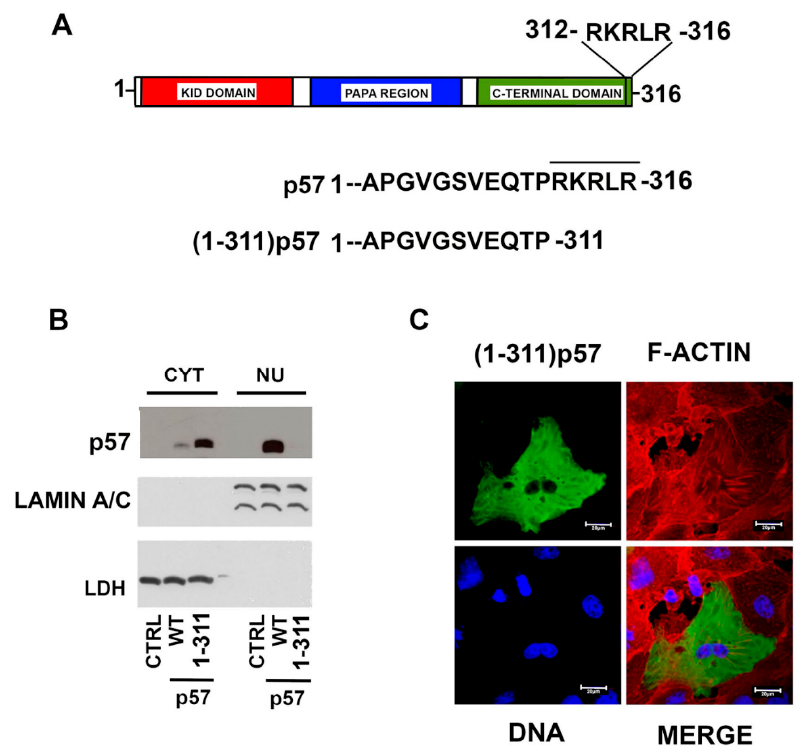
Figure 5. Relevance of the last five p57 residues in the nuclear localization of the protein. ( A ) Schematic representation of FL WT-p57 and (1–311)-p57. ( B ) WB analysis of p57 cytoplasmic/nuclear distribution in HEPG2 cells transfected for 24 h with the empty vector (CTRL) and the plasmids encoding the WT- and (1–311)-p57. Lamin A/C and LDH were employed to confirm the proper separation of nuclear and cytosolic fractions and as control for equal protein loading. ( C ) Representative immunofluorescence image of the overexpressed (1–311)p57 in HepG2 cells. p57 (green), DNA (blue), and F-ACTIN (red). Scale bar 20 µm. For further details refer to the Materials and Methods